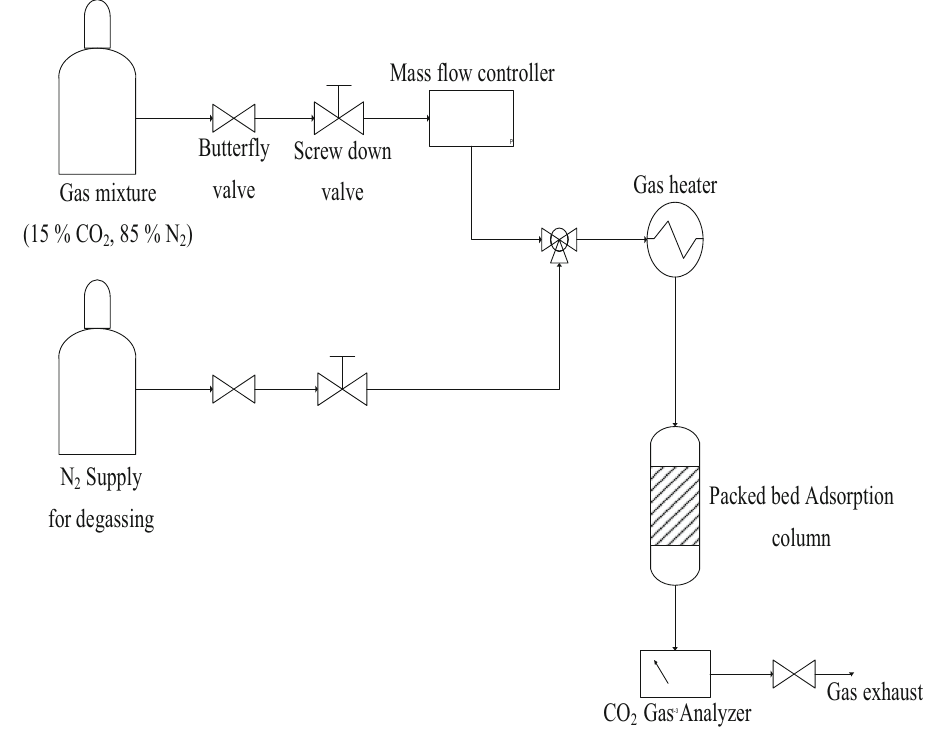
Fig. 1 Flow adsorption setup for the CO 2 separation from simulated flue gas. (Adapted from Yoro et al.